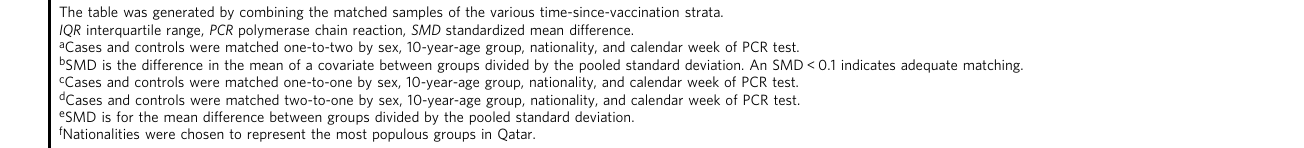
The table was generated by combining the matched samples of the various time-since-vaccination strata. IQR interquartile range, PCR polymerase chain reaction, SMD standardized mean difference. a Cases and controls were matched one-to-two by sex, 10-year-age group, nationality, and calendar week of PCR test. b SMD is the difference in the mean of a covariate between groups divided by the pooled standard deviation. An SMD<0.1 indicates adequate matching. c Cases and controls were matched one-to-one by sex, 10-year-age group, nationality, and calendar week of PCR test. d Cases and controls were matched two-to-one by sex, 10-year-age group, nationality, and calendar week of PCR test. e SMD is for the mean difference between groups divided by the pooled standard deviation. f Nationalities were chosen to represent the most populous groups in